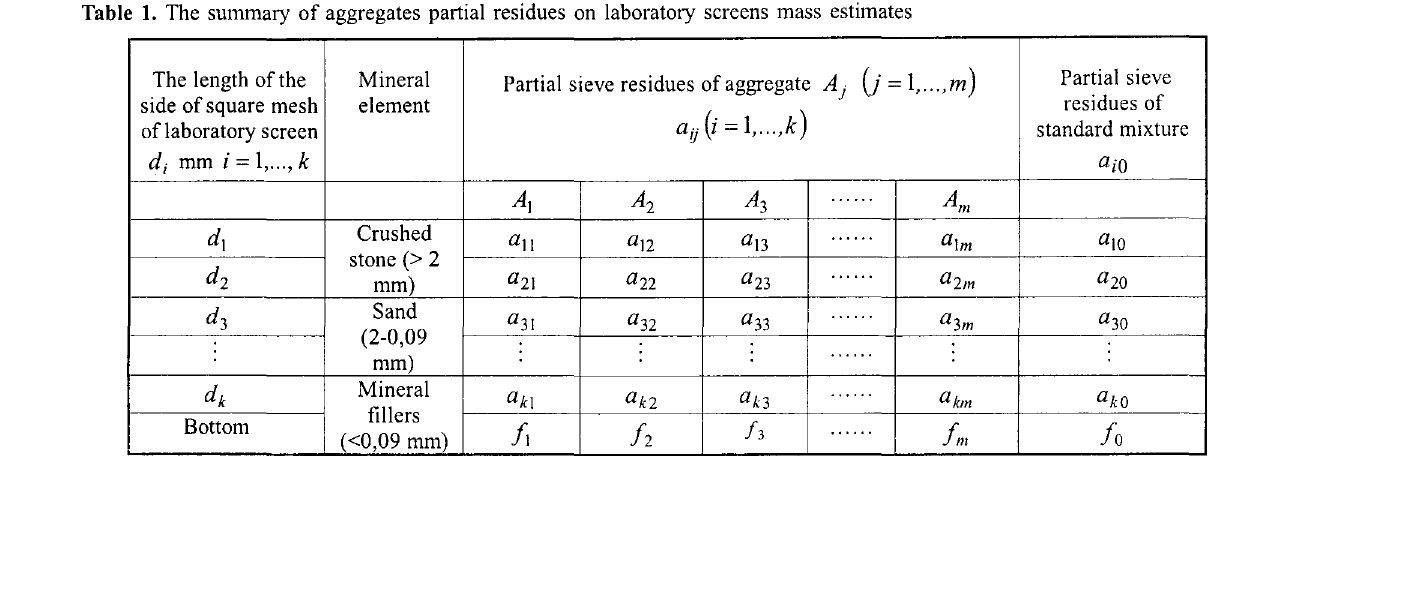
Table 1. The summary of aggregates partial residues on laboratory screens mass estimates The length of the Mineral Partial sieve residues of aggregate A J (J = l, ... ,m) Partial sieve residues of side of square mesh element au (i = 1, ... ,k) of laboratory screen standard